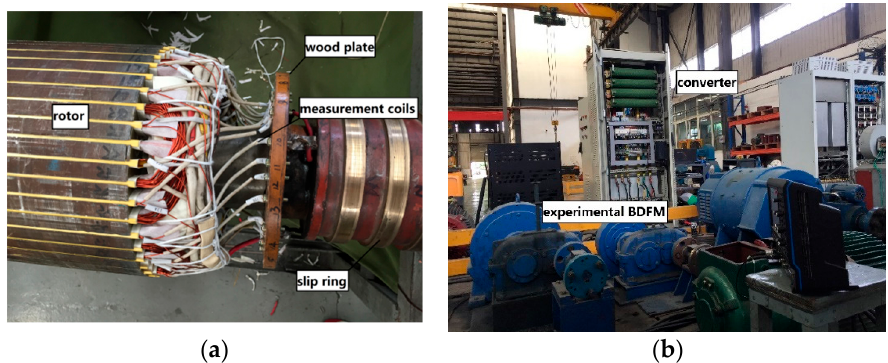
Figure 6. Scene of prototype test. ( a ) The rotor structure of prototype; ( b ) Prototype and converter.